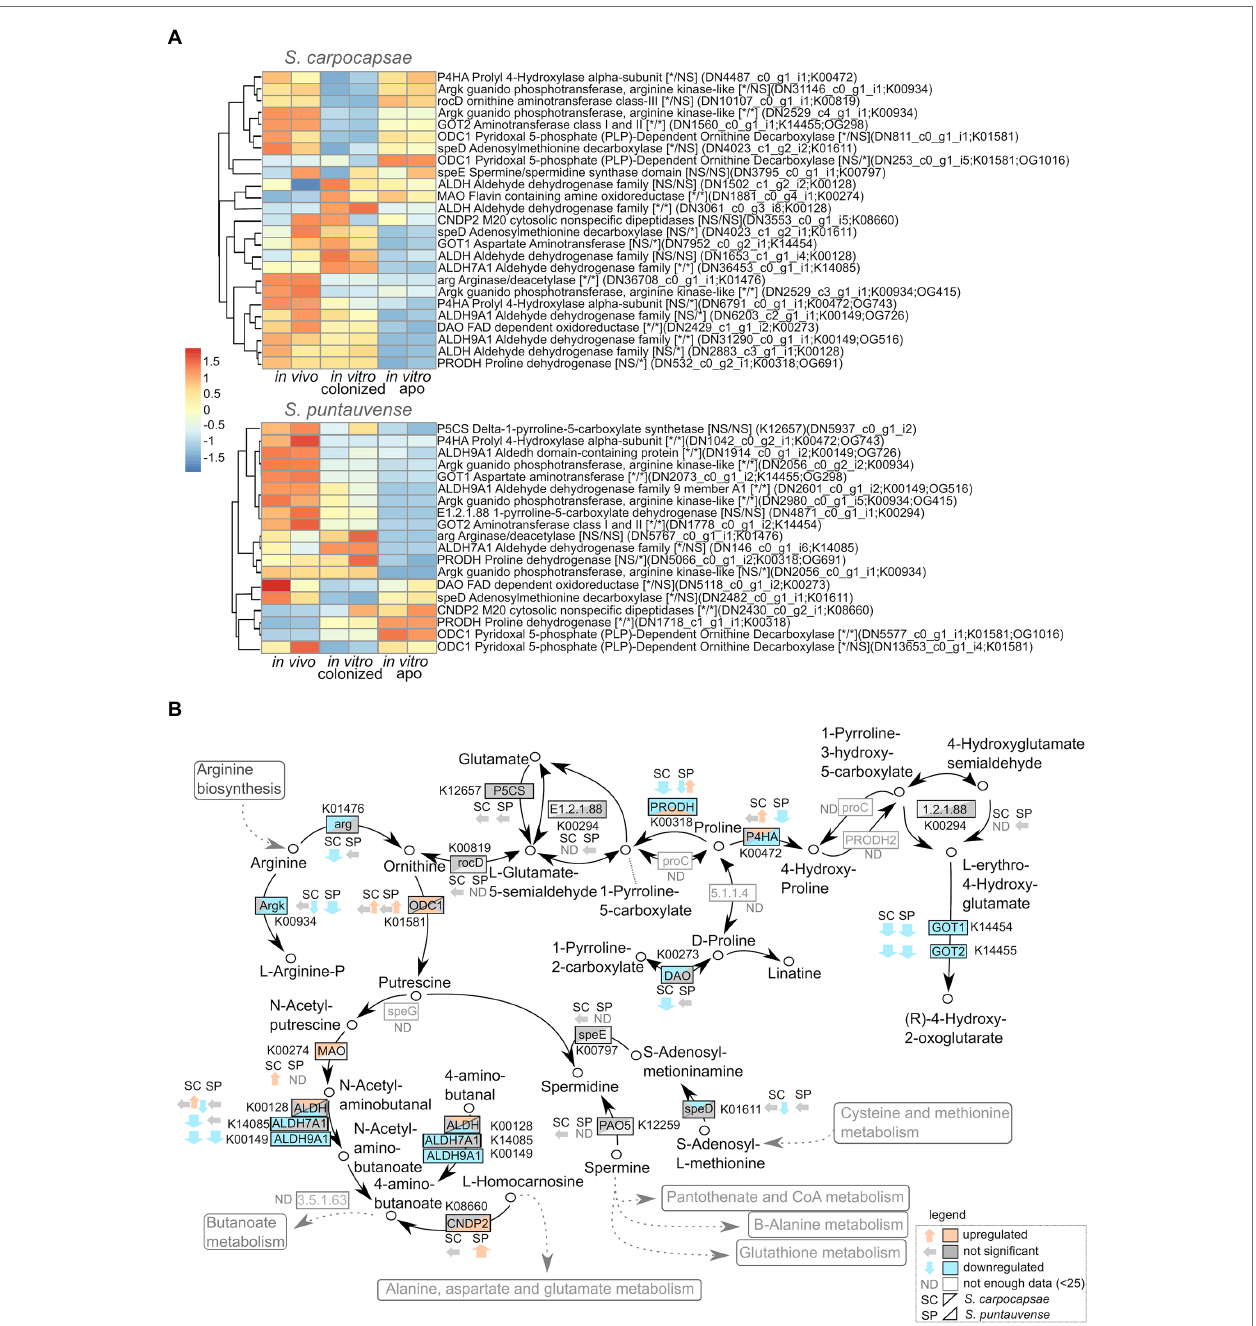
FIGURE 6 | Transcriptomic analysis of genes involved in the arginine and proline metabolism. (A) Heatmap of transcripts involved in the arginine and proline metabolism for the species S. carpocapsae and S. puntauvense produced by pheatmap (values centered and scaled in the row direction). For each condition, two technical replicates are showed in the heatmap. On the right side of the heatmap supplementary information is indicated including: annotation of the transcription (based on hmmer); significance of differentially expression based on cuffdiff and edgeR, “*” denotes significant difference, NS for not significant; first value is for the in vitro colonized rearing condition and second value is for the in vitro aposymbiotic rearing condition; the name of the transcript; the KEGG pathway detected; if applicable the name of the orthogroup that belongs to the transcript shared between the two nematode species (based on orthofinder analysis). (B) Map of the starch and arginine and proline metabolism pathway (ko00330) where observed expression in the in vitro aposymbiotic reared nematodes for both Steinernema species is